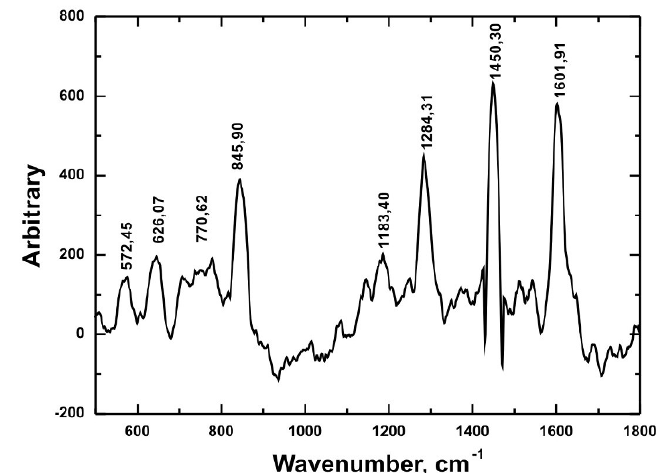
Figure 9. Experimental Raman spectra of the 4-ABA film on stainless steel.